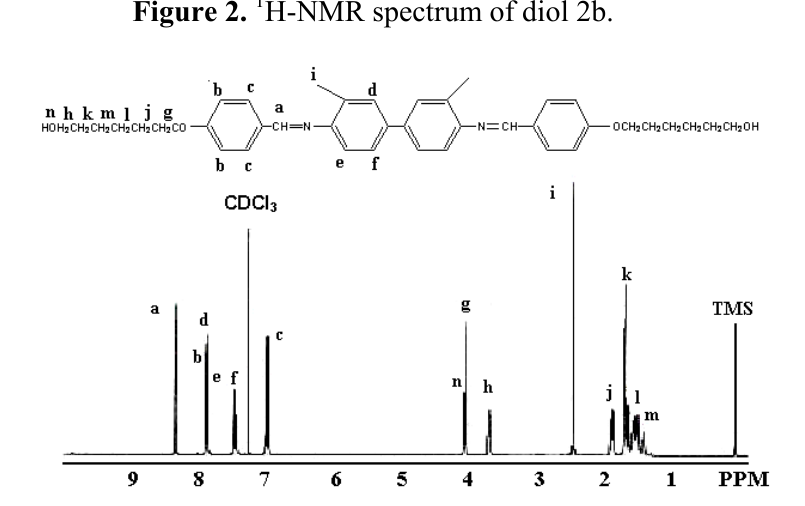
Figure 2. 1 H-NMR spectrum of diol